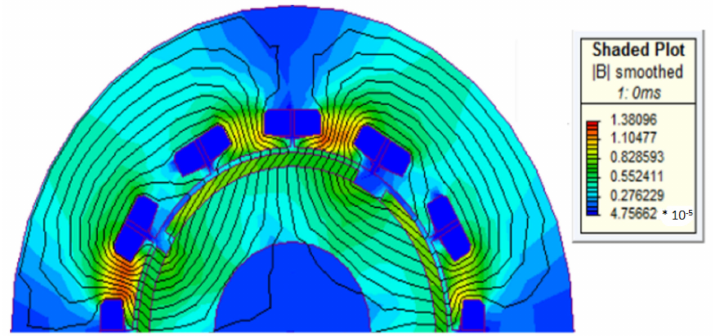
Figure 10. Flux plots in the asymmetrical rotor.